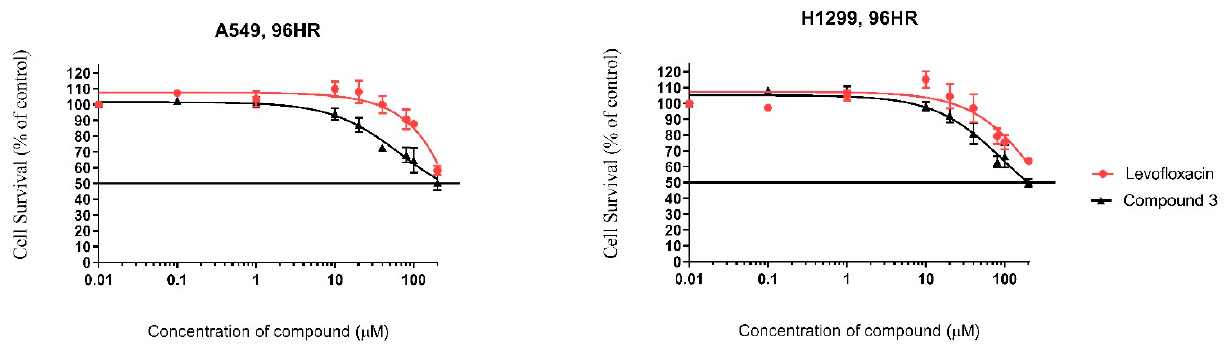
Figure 2. Cell viability of human dermal fibroblasts treated with various concentrations of com- pounds 2 and 3 and levofloxacin for 48 h.